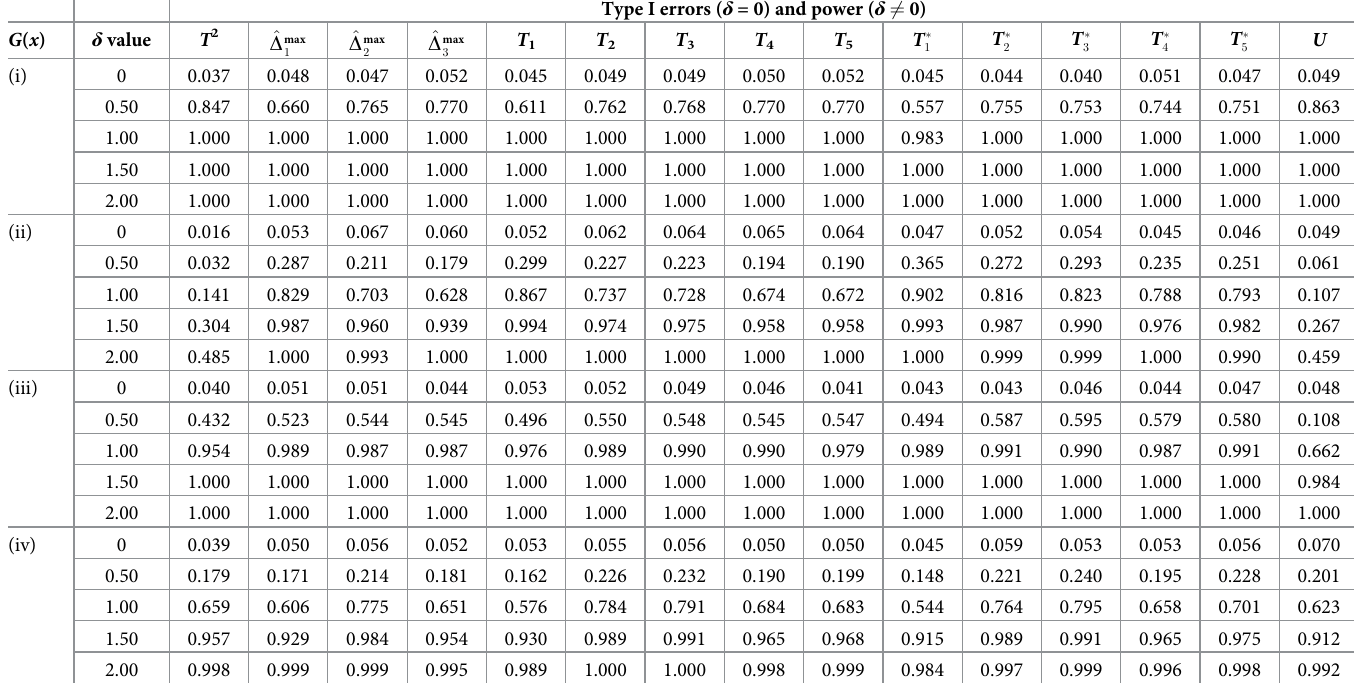
Table 2. Type I errors ( δ = 0) and power ( δ 6¼ 0) given by the investigated test statistics based on permutation approach in detecting location shift between two sam- ples generated from the four pairs of F ( x )and G ( x )with variance-covariance matrix I 4×4 and sample sizes n = m = 20.